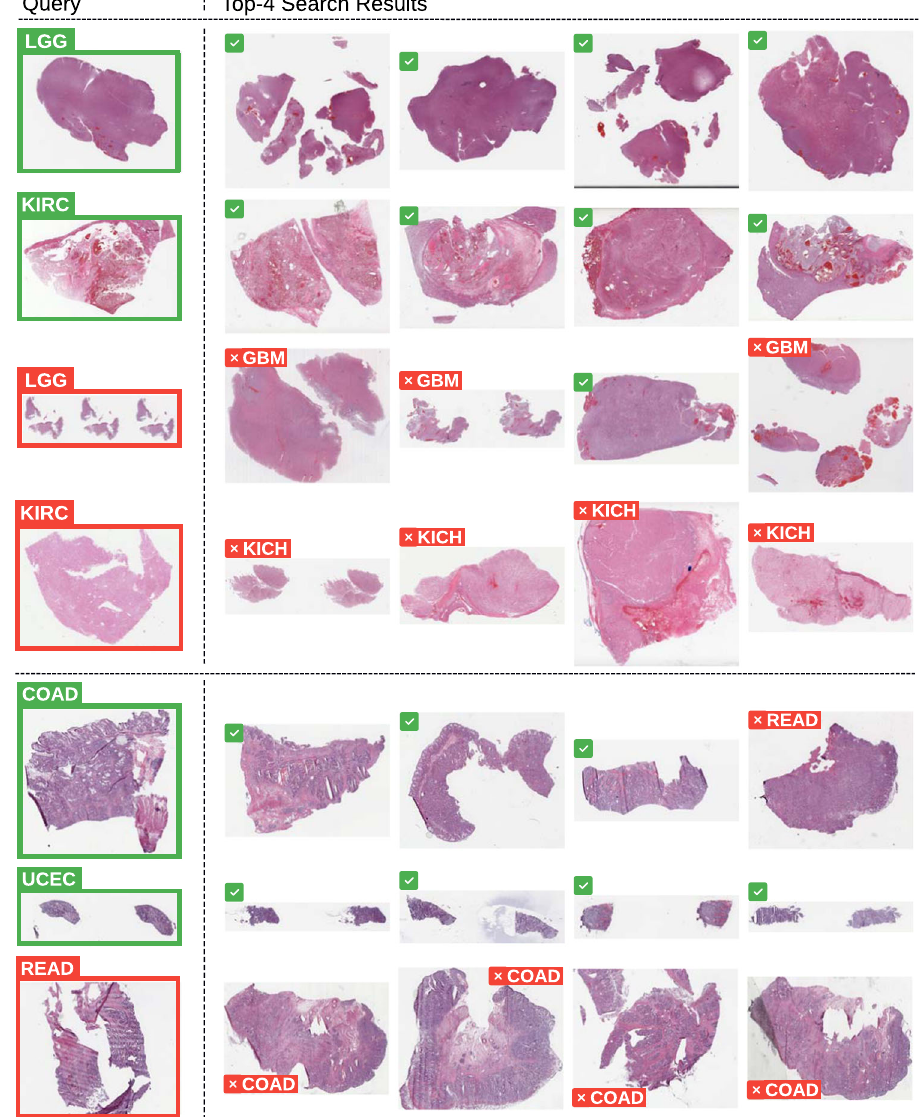
Fig. 2 Sample retrievals for cancer subtype categorization through majority votes. The top four slides are of permanent diagnostic slides whereas the bottom three slides are of frozen section slides. The misclassi fi ed and successful queries are marked with red and green boundaries, respectively (for abbreviations, see Table